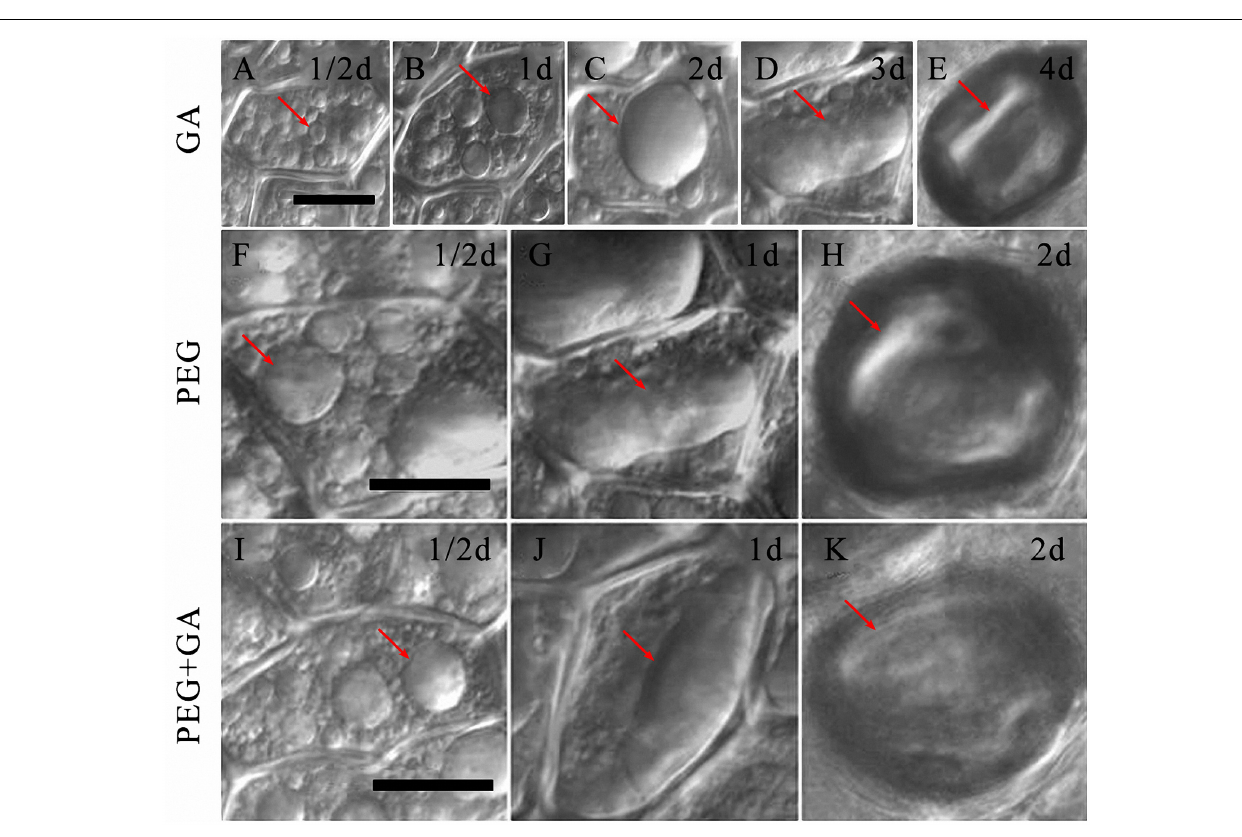
When the HO-1 inducer and NO donor were, respectively, added to PEG + GA, a large central vacuole of aleurone cell was not observed at 1 day ( Figures 7A,E ) and 2 days ( Figures 7B,F ). A large central vacuole did not emerge